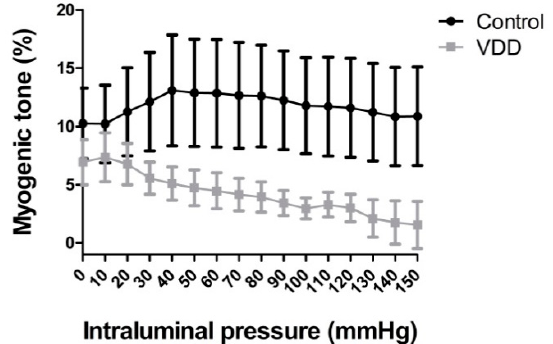
Figure 4. Spontaneous tone of coronary arterioles (%, n = 6–6). Repeated measures ANOVA, Bonferroni. Mean ± SEM.